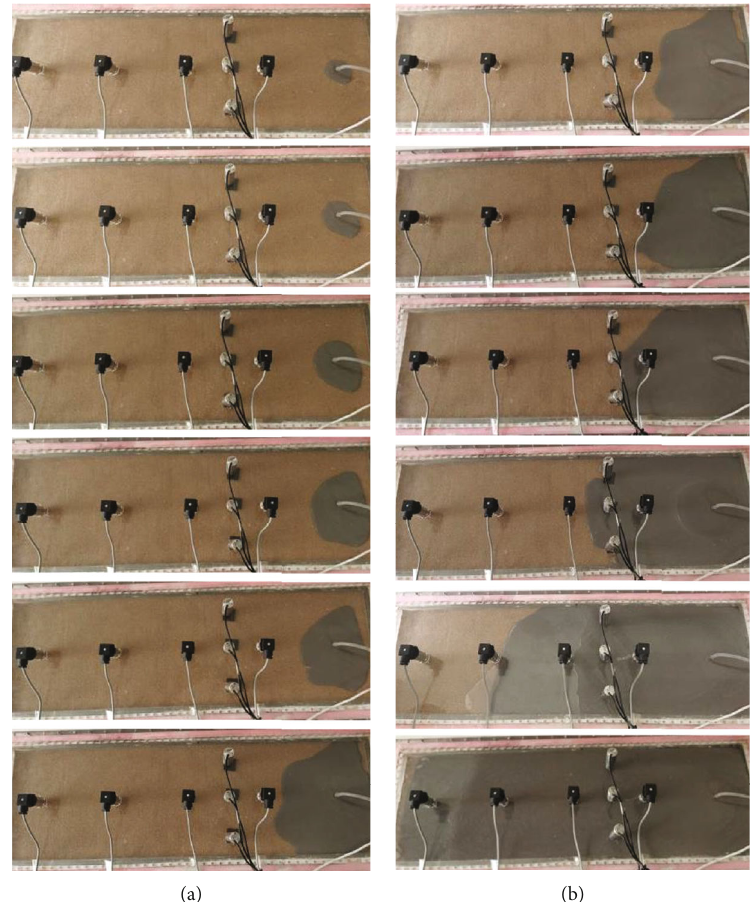
Figure 7: Slurry fl ow during nonpressure injection. (a) Radial fl ow (0 – 90 s). (b) Bidirectional fl ow (90 – 630 s).